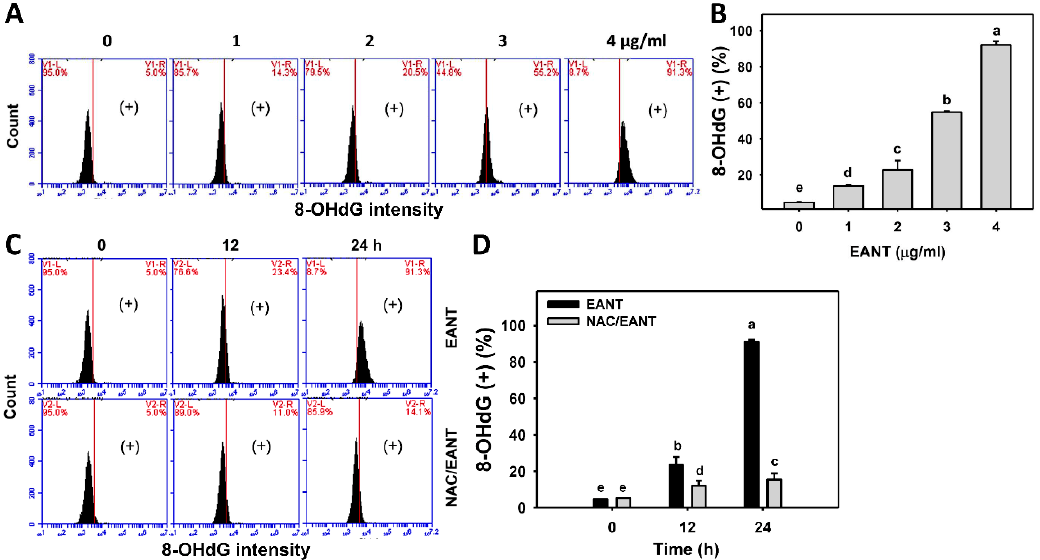
Figure 10. 8-OHdG content of EANT-treated leukemia cells. ( A and B ) Histogram and statistical analysis for 8-OHdG content. (+) on the right side of each panel is regarded as the population of 8-OHdG (+) (%). HL-60 cells were treated with EANT (1 h, 0 to 4 μ g/mL). The control contained 0 μ g/mL EANT but 0.1% DMSO. ( C and D ) Histogram and statistical analysis for 8-OHdG content of HL-60 cells following NAC/EANT treatment. NAC/EANT indicates that cells were either pretreated with NAC (5 mM, 1 h) or post-treated with EANT (0 and 4 μ g/mL for 0, 12, and 24 h). Data, mean ± SD ( n = 3). Data showing different letters on the top reveal a significant difference ( p < 0.0001 for multiple comparisons).